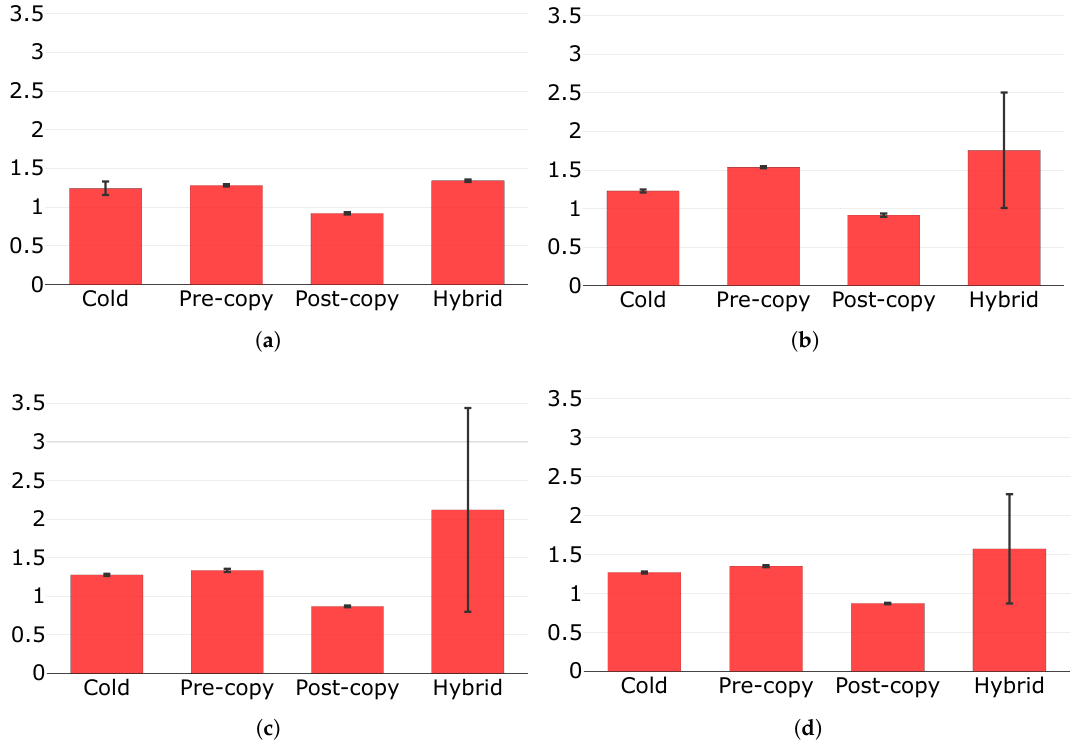
Figure 10. Resume times (s) under: ( a ) configuration A; ( b ) configuration B; ( c ) configuration C; and ( d ) configuration